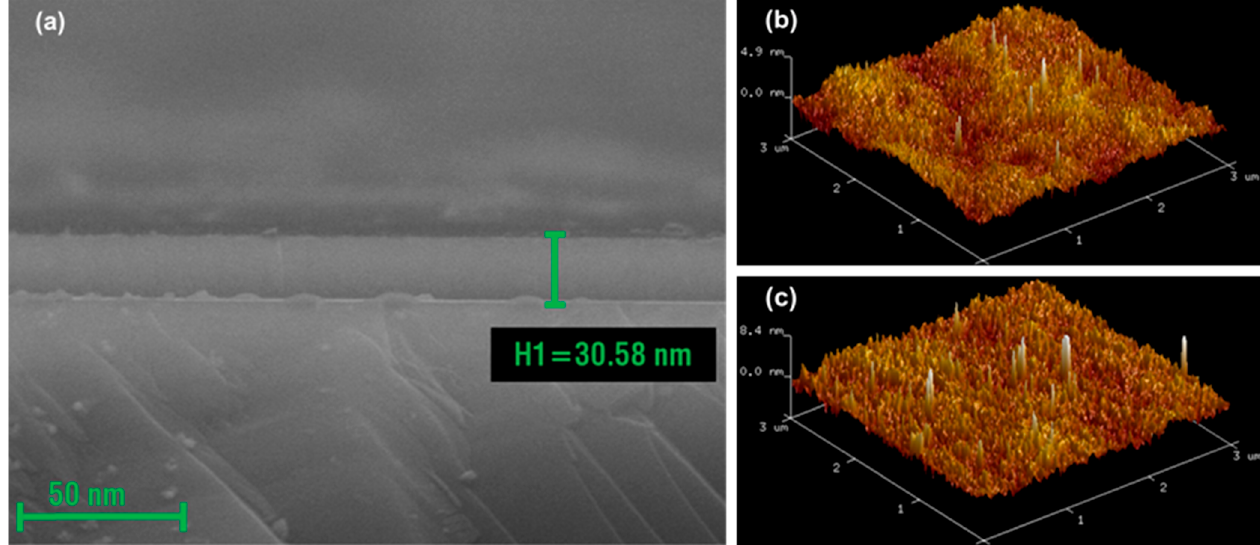
Figure 3. ( a ) Section image of 30 nm MgO coating observed by SEM; ( b , c ) the surface roughness images of 20 nm and 30 nm MgO coatings characterized by AFM.